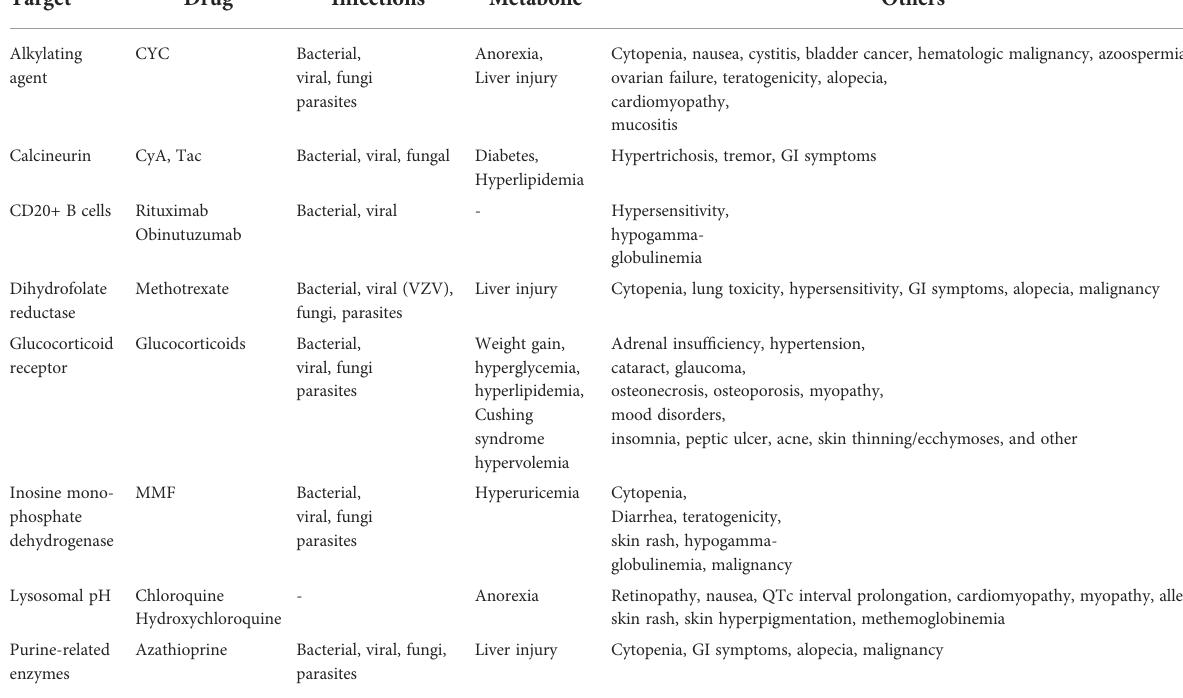
TABLE 1 Severe adverse effects of drugs in use for the treatment of